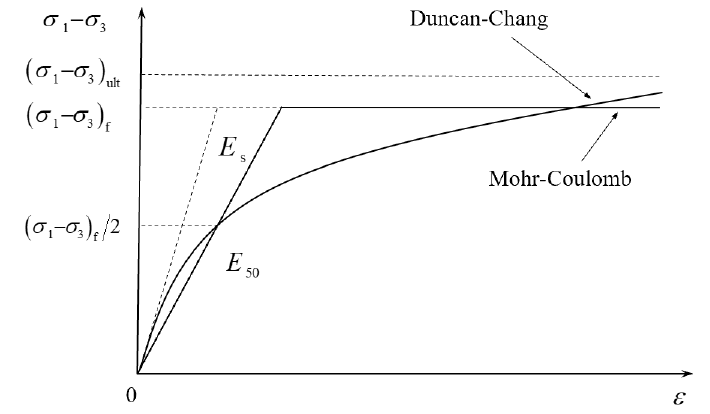
Figure 3. Hyperbolic model.